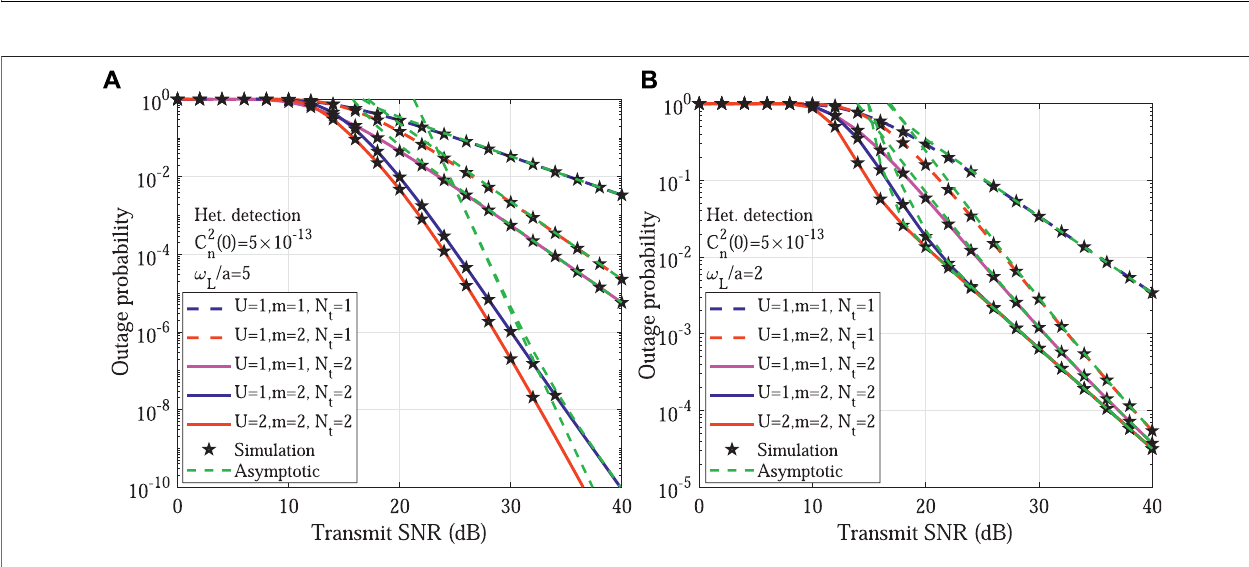
Frontiers in Communications and Networks |